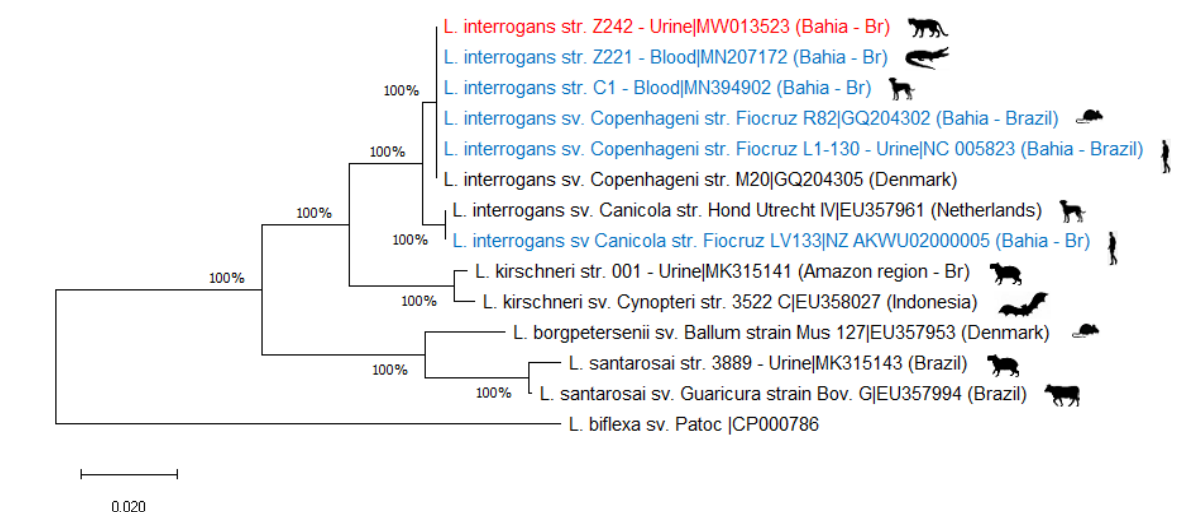
Figure 1. Phylogenetic tree built with secY gene sequence analysis recovered from blood sample of an Ocelot ( Leopardus pardalis ). Sequence obtained directly from clinical samples (urine) studied in this work are indicated in red, sequences obtained from a L . interrogans strain from, dog, broad-Snouted Caiman, rodents isolated and human, in the same regions are in blue. Additional sequences corresponding to isolates obtained elsewhere from a variety of hosts are indicated in black. After the vertical bar, the GenBank accession number is reported for each sequence. The analysis was made using the maximum-likelihood method (Tamura–Nei model). The support for the branching order was determined by 1000 bootstrap .